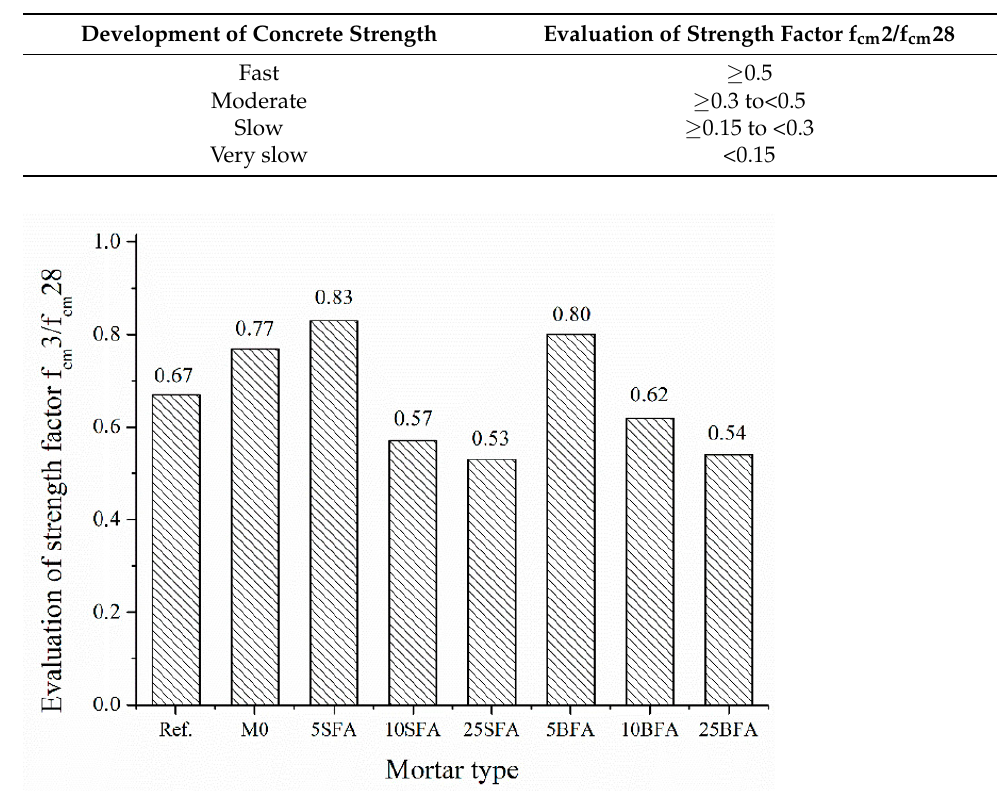
Figure 6. Early strength development of tested